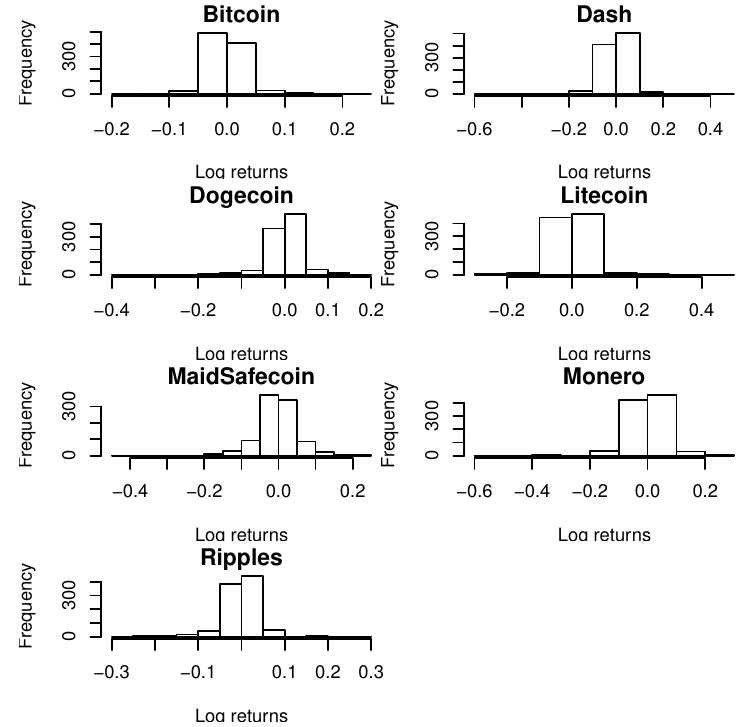
Figure 1. Histograms of daily log returns of the exchange rates of the seven cryptocurrencies versus the U.S. Dollar from 23 June 2014 until 28 February